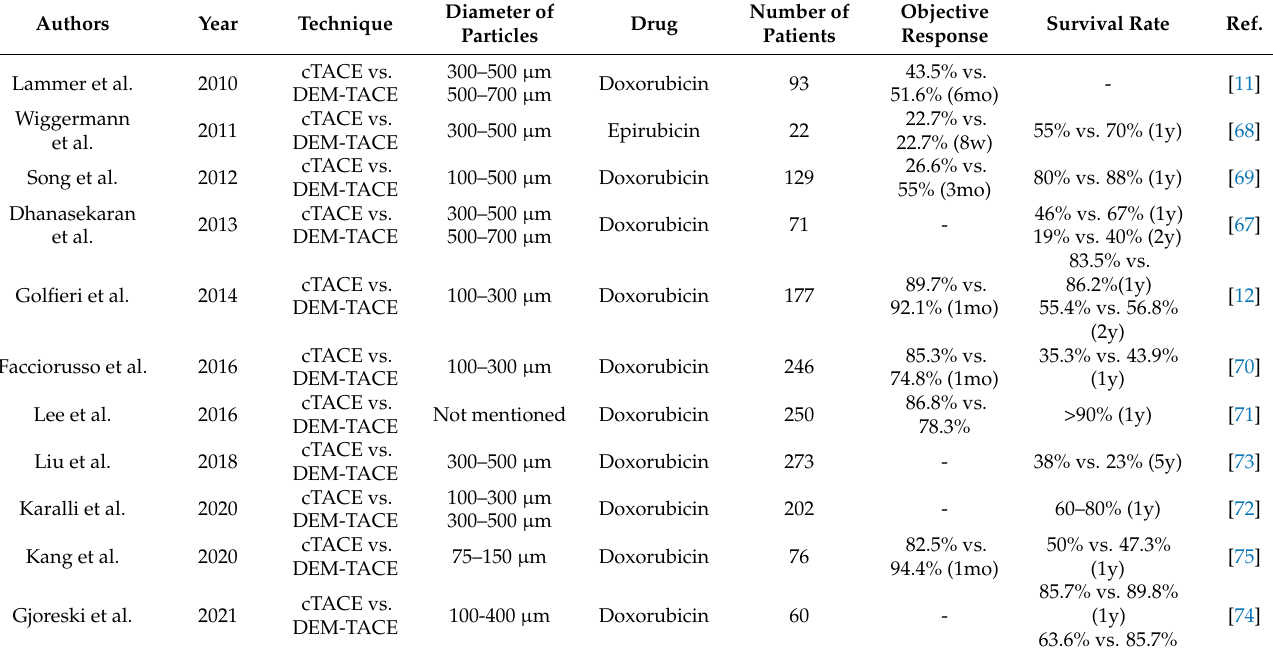
Table 2. Results in terms of efficacy of selected studies comparing conventional and drug-eluting microsphere transarterial